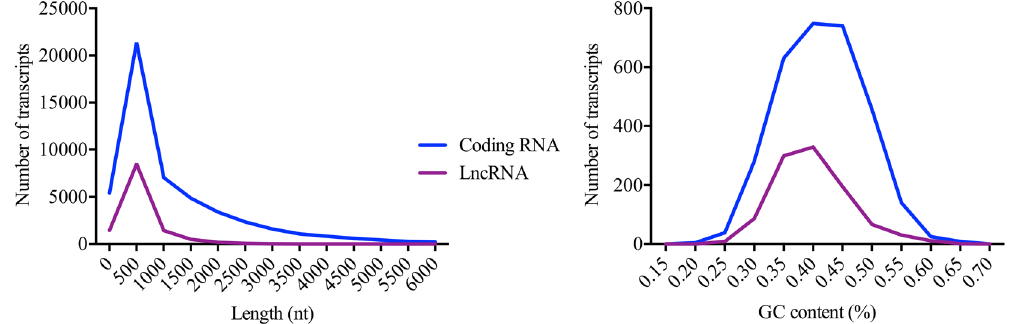
Figure 1. Features of predicted lncRNAs from the WT and rag1 + / − zebrafish transcriptomes. ( A ) Length distribution of predicted lncRNAs and coding transcripts. ( B ) Comparison of GC content between lncRNAs and coding transcripts.